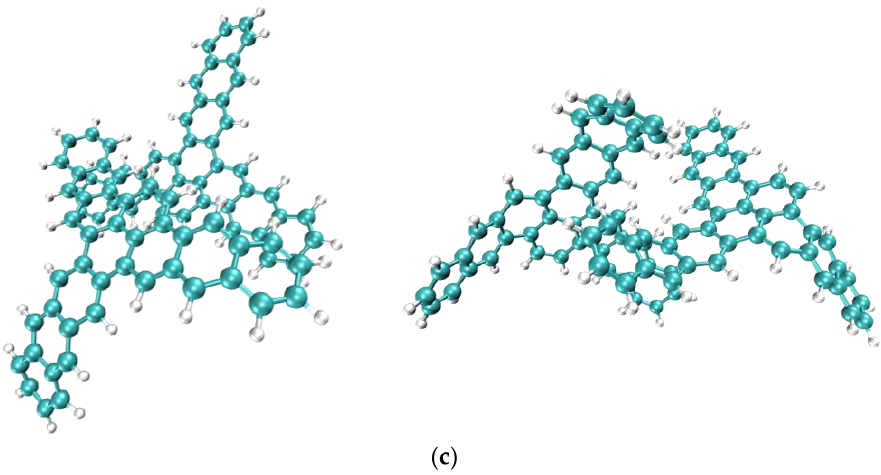
Figure 6. Aggregation behavior of three asphaltene molecules. ( a ) AsphalteneO: face – face stacking; ( b ) AsphalteneT: offset stacking (left) and T-shaped stacking (right), and ( c ) AsphalteneY: offset stacking (left) and crossed stacking (right).